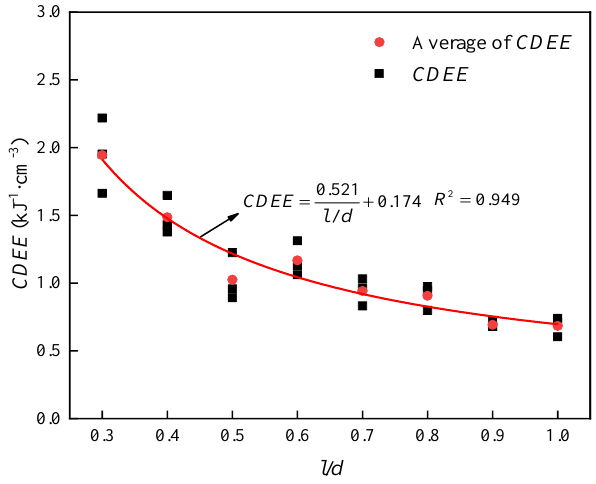
Figure 14. The energy efficiency of crushing density and l / d